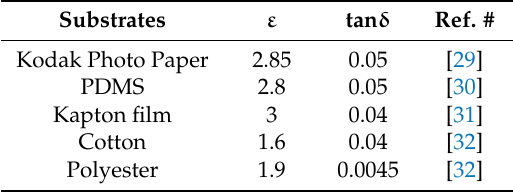
Table 3. Dielectric properties of commonly used